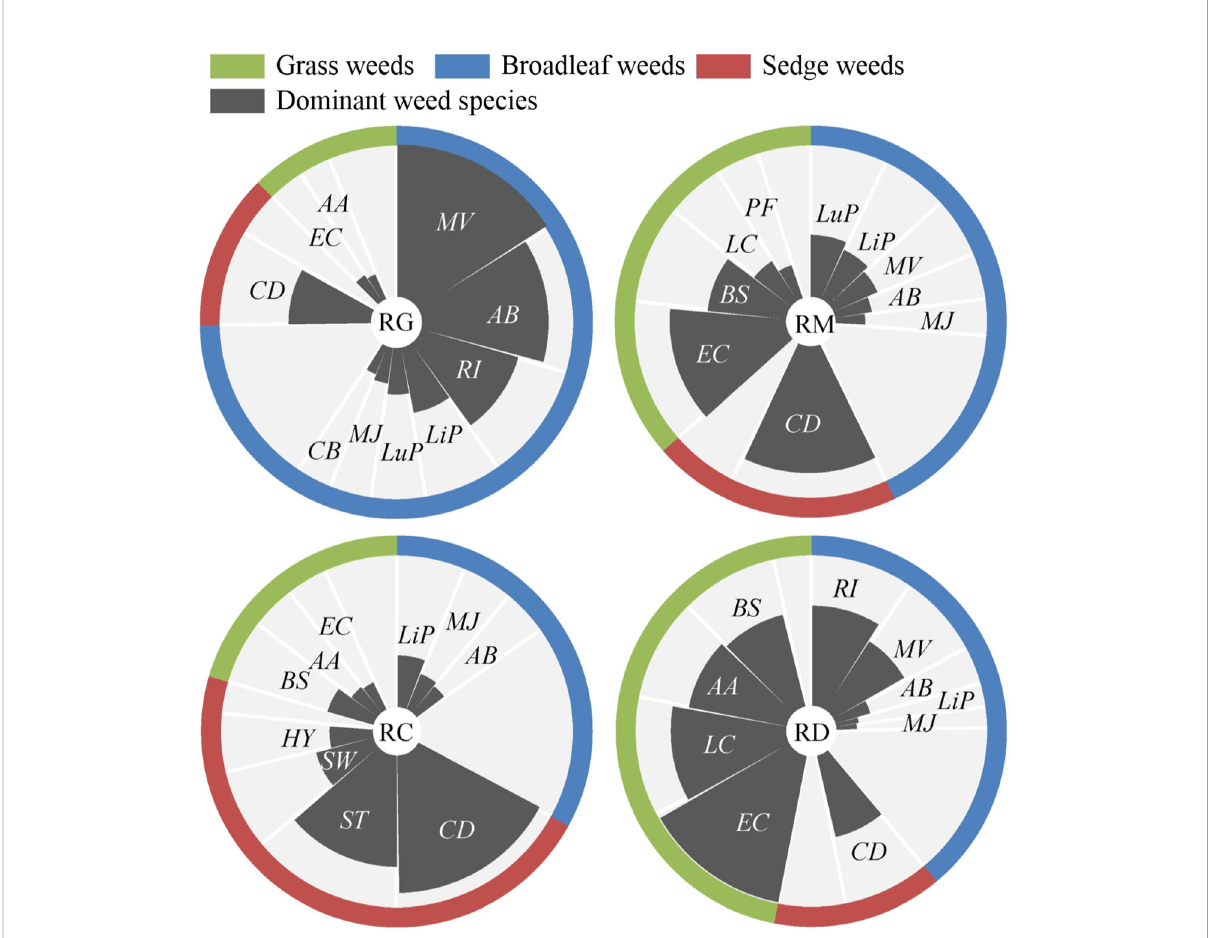
FIGURE 3 The composition of grass, broadleaf and sedge weeds and the ten dominant weed species in the soil seed bank (by important value of all three sampling fi elds) of different organic rice production modes. RG, rice-green manure rotation; RM, rice monoculture; RC, rice-cray fi sh co-culture; RD, rice-duck co-culture. AA, Alopecurus aequalis ; AB, Ammannia baccifera ; BS, Beckmannia syzigachne ; CB, Capsella bursa-pastoris ; CD, Cyperus difformis ; EC, Echinochloa crusgalli ; HY, Heleocharis yokoscensis ; LC, Leptochloa chinensis ; LiP, Lindernia procumbens ; LuP, Ludwigia prostrata ; MJ, Mazus japonicus ; MV, Monochoria vaginalis ; PF, Polypogon fugax ; RI, Rotala indica ; ST, Scirpus triangulatus ; SW, Scirpus wallichii